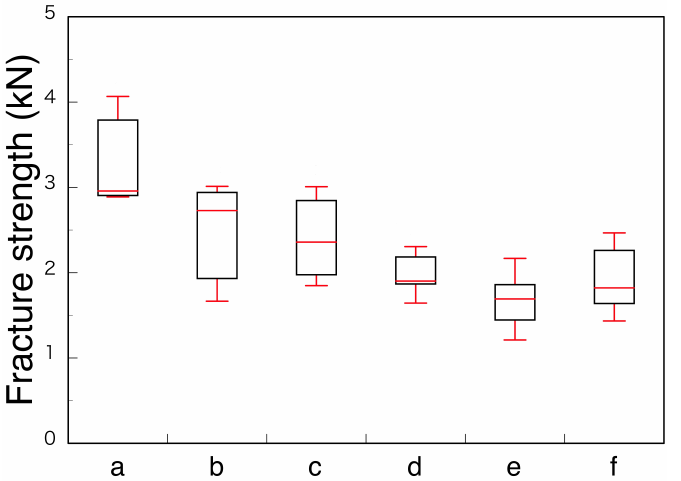
Figure 16. Box plot of fracture test results for the superstructure of monolithic zirconia crown ( a – c ) and ceramic abutment veneered with lithium disilicate ( d – f ). Adopted from Refs. [38–40].